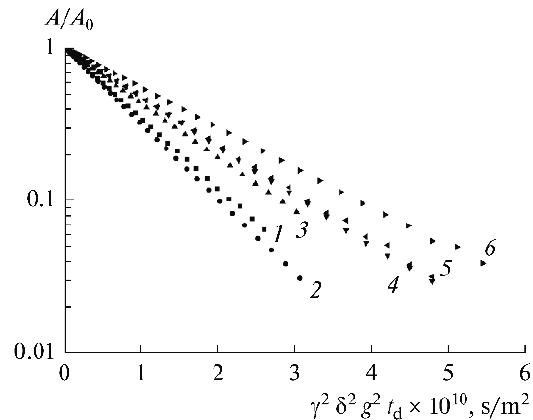
Figure 32. Dependence of amplitudes of spin-echo signals of 7 Li on the squared amplitude of mag- netic field gradient pulse (diffusion decay). The numbers correspond to the electrolyte composition numbers (Table 10) [65].